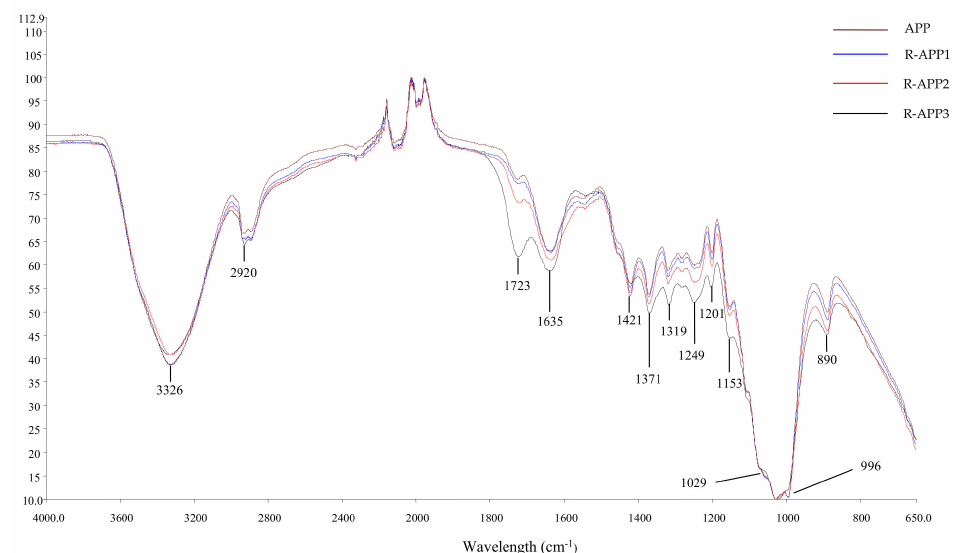
Figure 4. FTIR spectra of native and irradiated APP at doses of 10 kGy (R-APP1), 100 kGy (R-APP2), and 1000 kGy